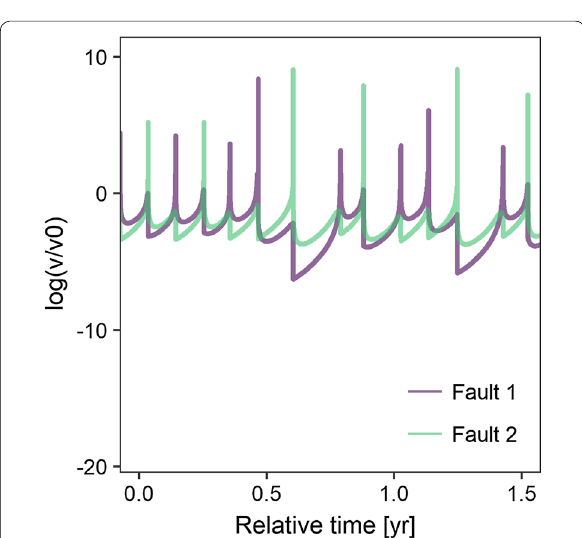
Fig. 4 Temporal evolution of the common logarithmic slip rate log( v / v 0 ) at the fault centers for the same setting as Fig. 3b of x / R 0.05, during the irregular =